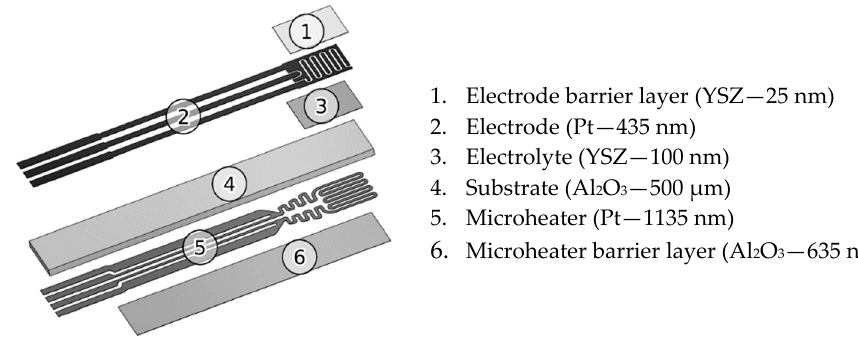
Figure 1. Schematic sensor setup and film thickness, adapted from [25].